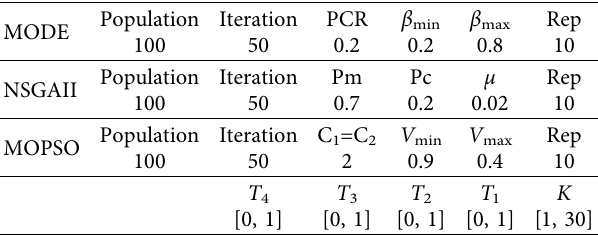
Table 4: Te parameters of the MOPSO algorithm. MODE